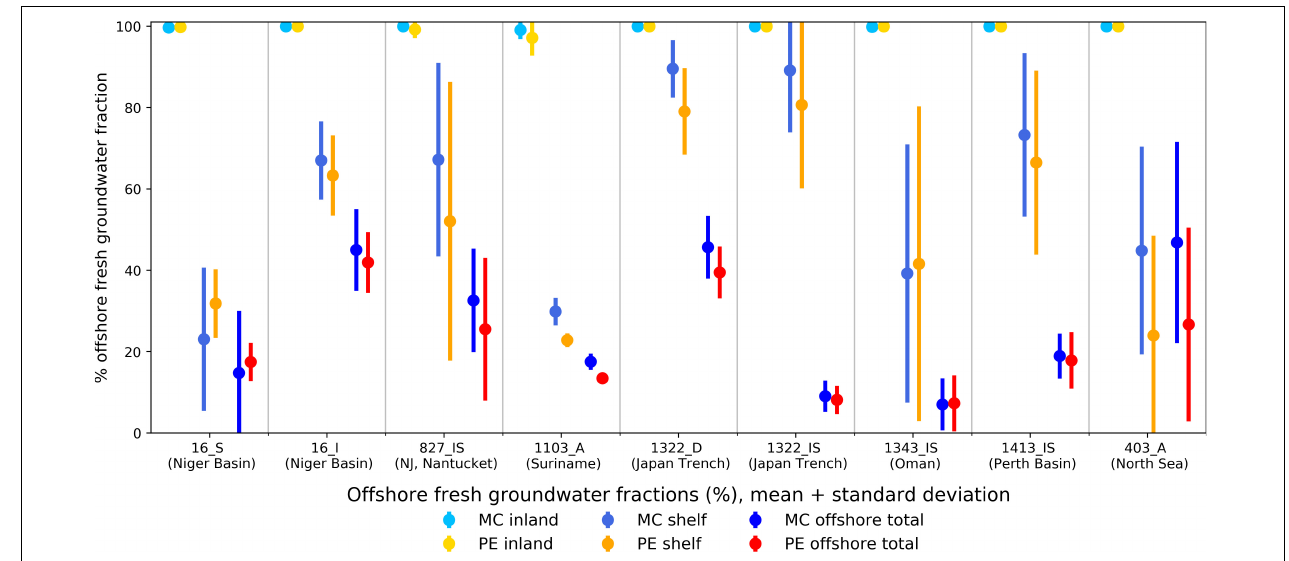
FIGURE 9 | Estimated mean and standard deviation present-day offshore FGFs for both modeling concepts and the seven selected COSCAT regions and their respective coastal types considered.